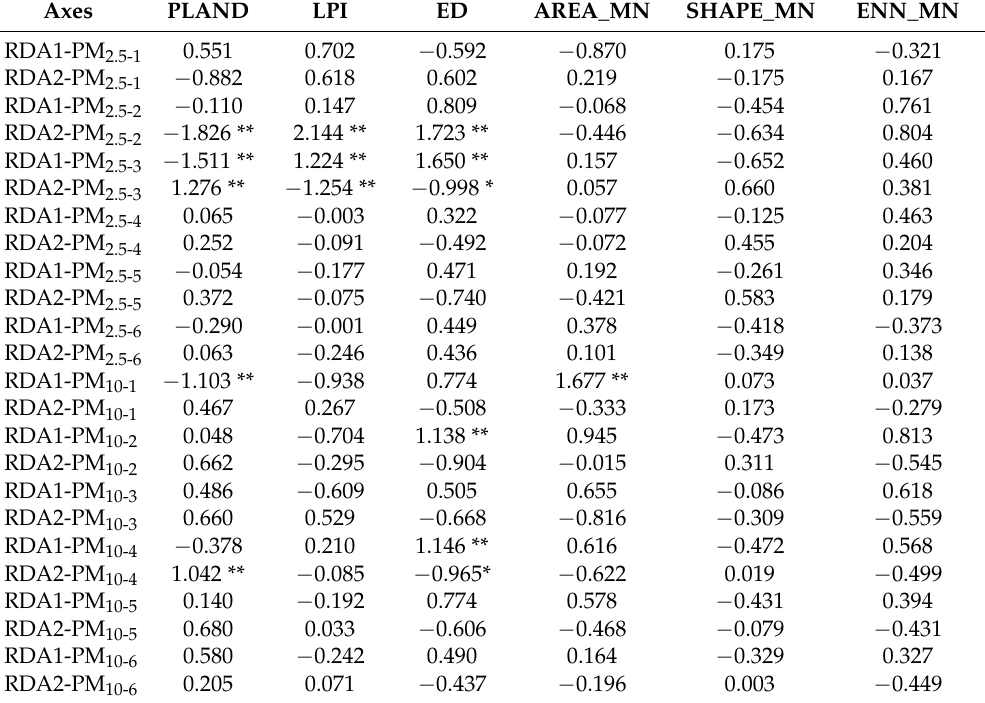
Table 4. Correlation between landscape metrics and redundancy analysis (RDA)